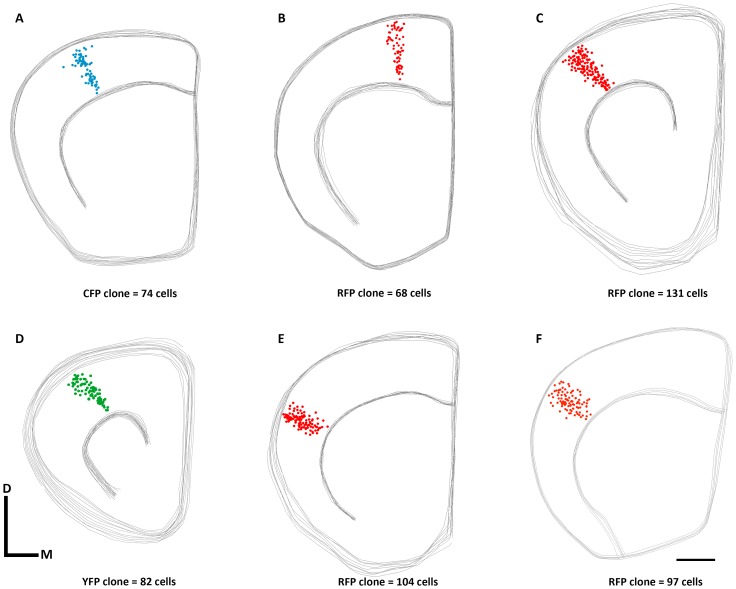
3D reconstruction of clones labeled in the neocortex.(A–F) 3D reconstructions from the six clones analyzed in the neocortex. Clone size is indicated below each 3D reconstruction. Scale bar in F is 1 mm and applies to A-F. Orientation of diagrams: D, dorsal; M, medial.